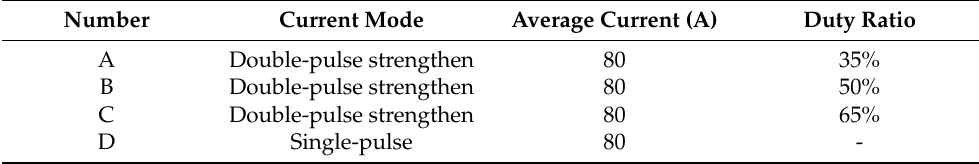
Figure 2. Schematic diagram of the robot additive manufacturing process. Table 2. Forming process parameters of four depositions. Table 2. Forming process parameters of four depositions.